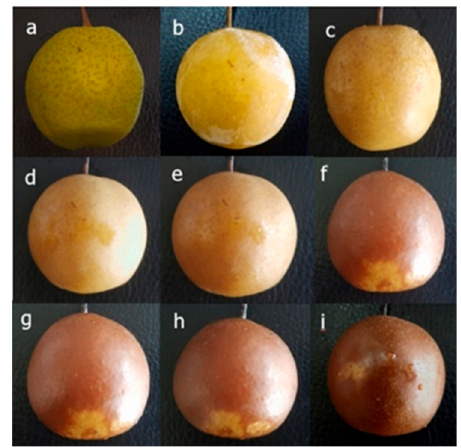
Figure 1. Changes in chlorophyll ( A ) and carotenoid contents ( B ) in “Ruaner” pear during the freezing–thawing stage. Different letters indicated significant differences between thawing time treated and control (Duncan’s multiple range test, p < 0.05).